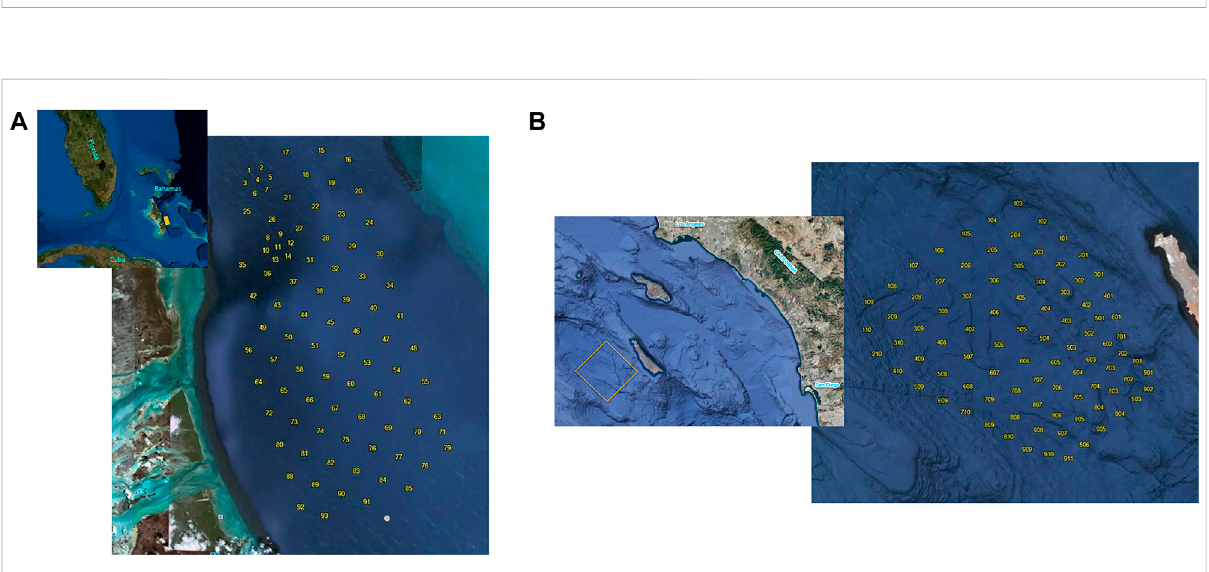
FIGURE 2 (A) Layout ofbottom-mountedhydrophones atAUTEC.Spacingbetween hydrophones 15through91isapproximately4 km.Spacingbetween hydrophones 1 to 14 is approximately 2 km. The CS-SVM classi fi er was not running on hydrophones 8 to 14 during the study window. (B) Layout of bottom-mounted SOAR hydrophones used in the study. Spacing between hydrophones varies with depth from approximately 3.5 – 5